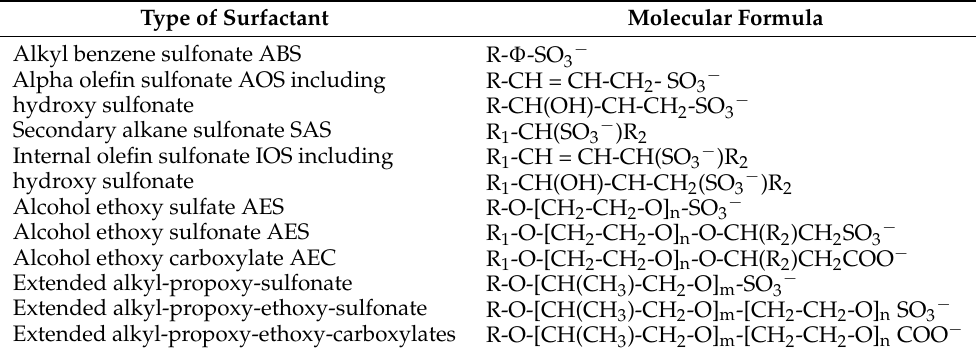
Table 2. Principal surfactant species recommended as components of high-performance mixtures for EOR (R = alkyl group, often branched or